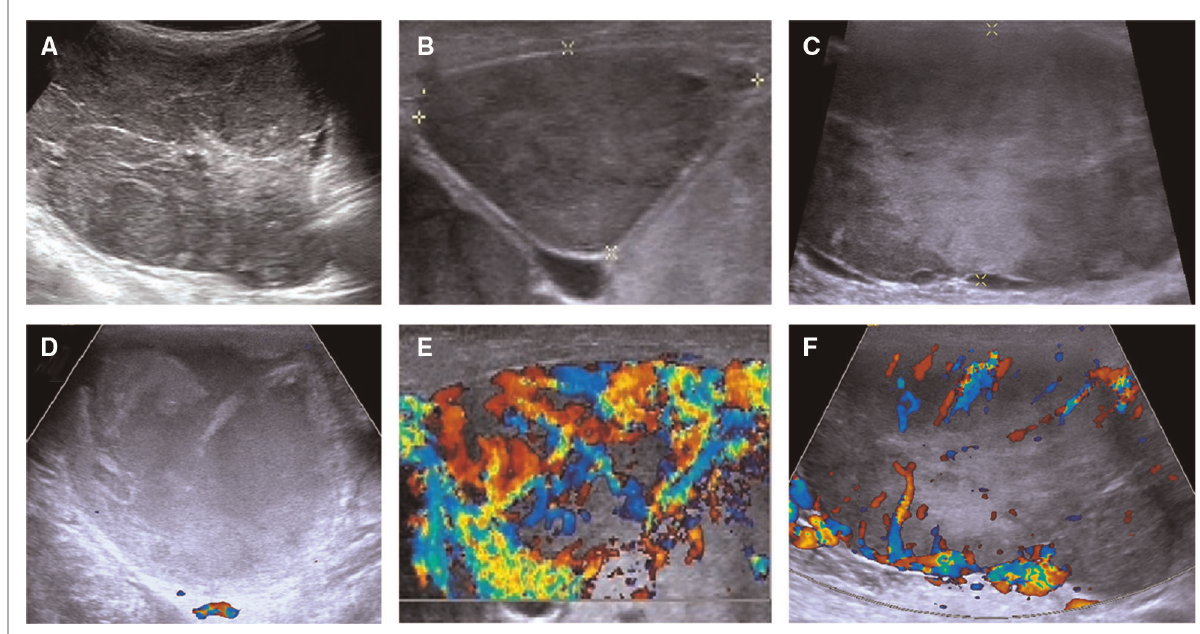
FIGURE 1 Ultrasonographic images of the thyroid and lateral lymph nodes. ( A ) The thyroid tissue displayed a heterogeneous echoic appearance on gray-scale sonography. ( B,C ) Cervical lymph nodes showed round shape and absence of hilum on gray-scale sonography. ( D – F ) CDFI showed different vascular distribution of cervical lymph nodes. ( D ) A mixed-echoic cervical lymph node with more than 90% of cystic change revealed no blood fl ow signal inside this lymph node. ( E ) A heterogeneous echoic cervical lymph node showed rich blood fl ow signal inside and around this lymph node. ( F ) A heterogeneous echoic cervical lymph node showed rich blood fl ow signal around this lymph